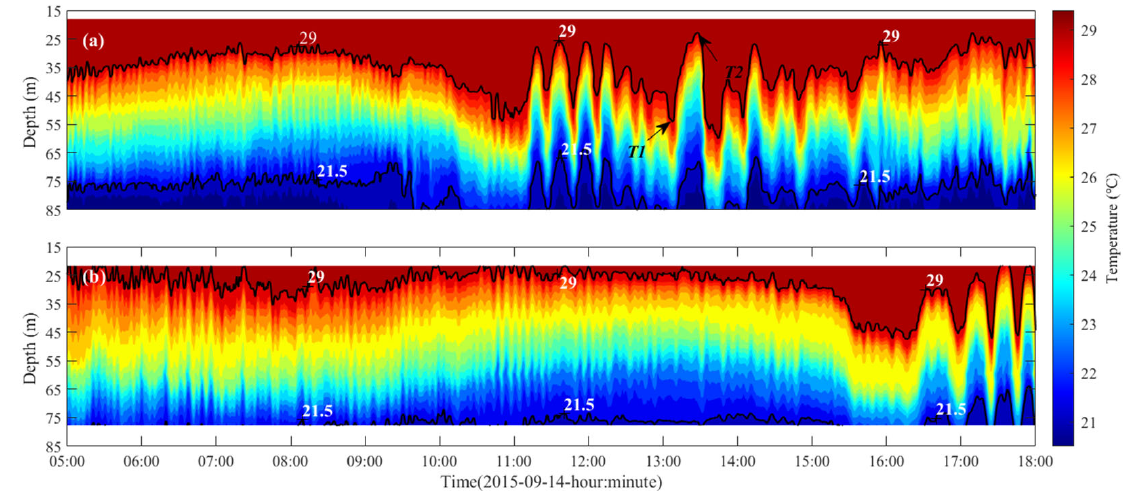
Figure 3. Temperature versus time and depth measured at points ( a ) S and ( b ) R.